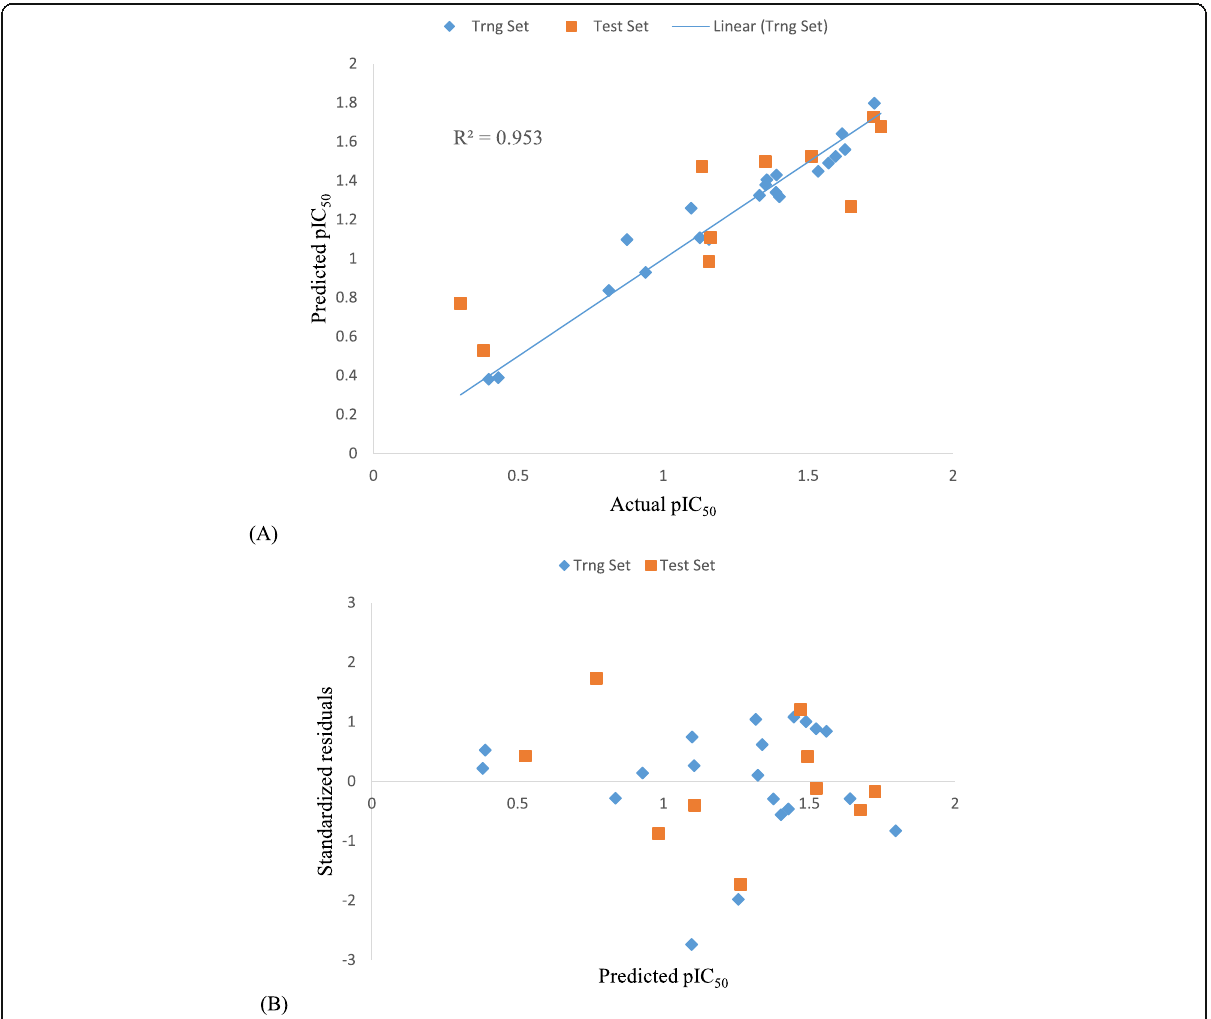
Fig. 3 a Plot of actual pIC 50 against predicted pIC 50 . b Plot of predicted pIC 50 against standardized